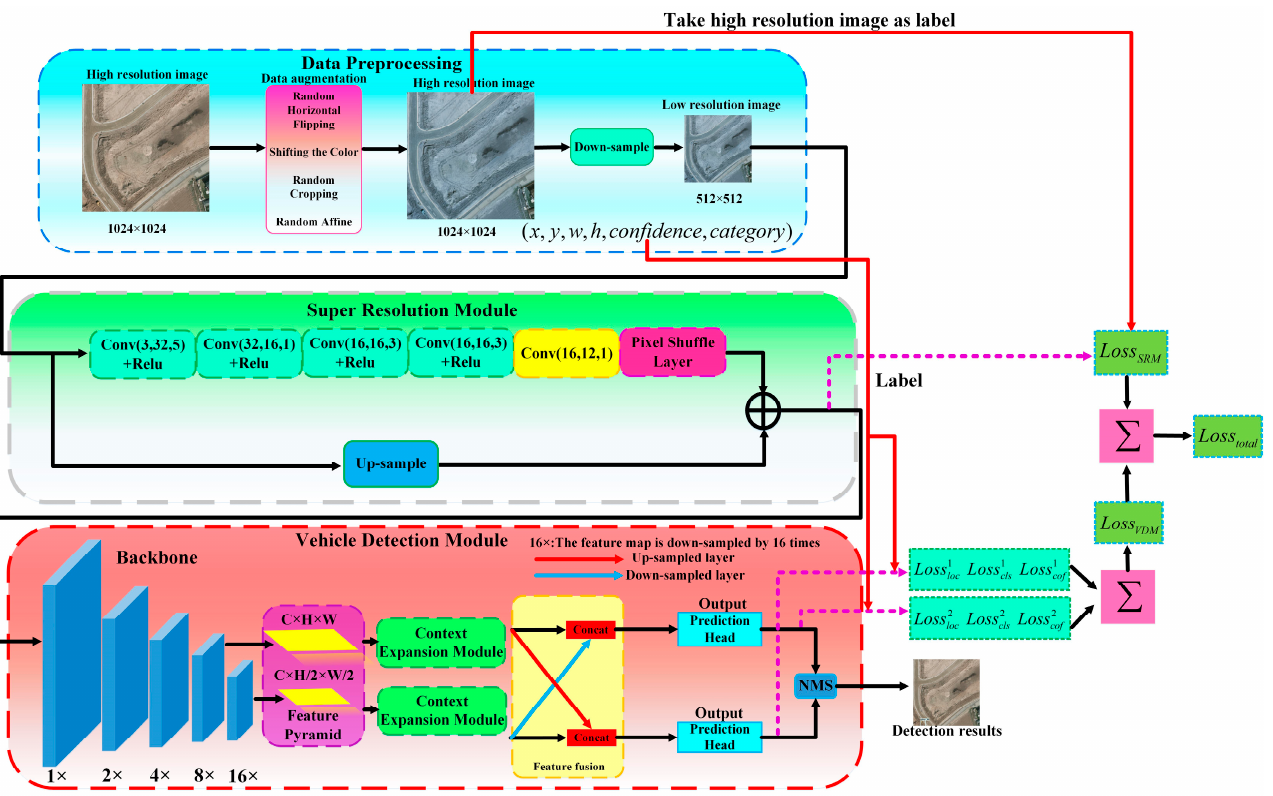
Figure 2. The architecture of SuperDet. SuperDet consists of three parts, namely, Data preprocessing, Super resolution module and Vehicle detection module.